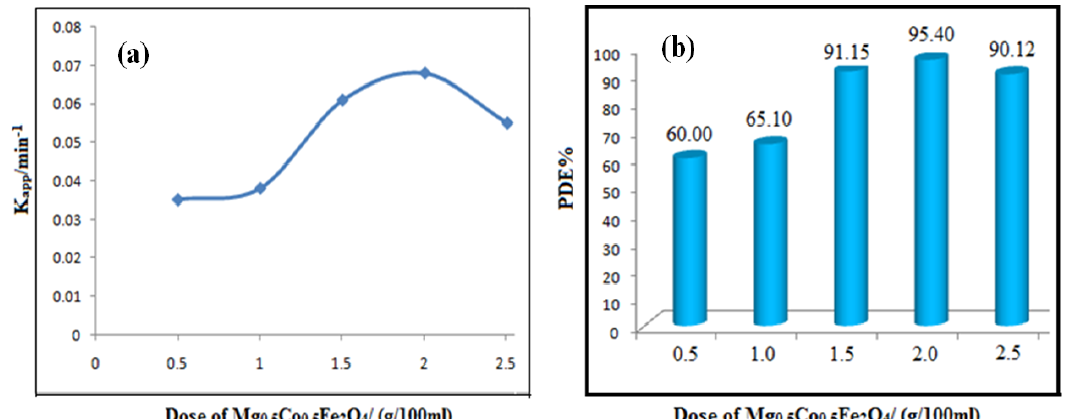
Fig.10. Effect of catalyst dose on the (a) apparent rate constant of reaction (b) PDE %, at conditions: cat. Dose = (0.5-2.5) g/100mL, Congo red dye conc.= 30 ppm, initial pH of solution= 5.5 and T= 303K